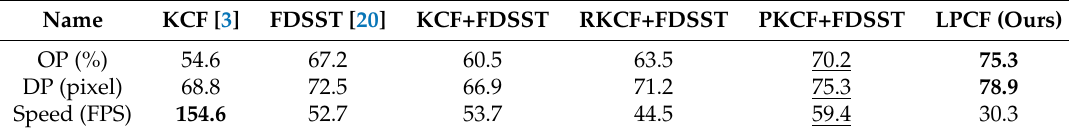
Table 1. Comaprison with basline trackers in distance precision (DP) at a threshold of 20 pixels, mean overlap precision (OP) at a threshold 0.5 of OPE evaluation, and mean frame-per-second (FPS) of 100 sequences. The best results and second highest values are highlighted by bold and